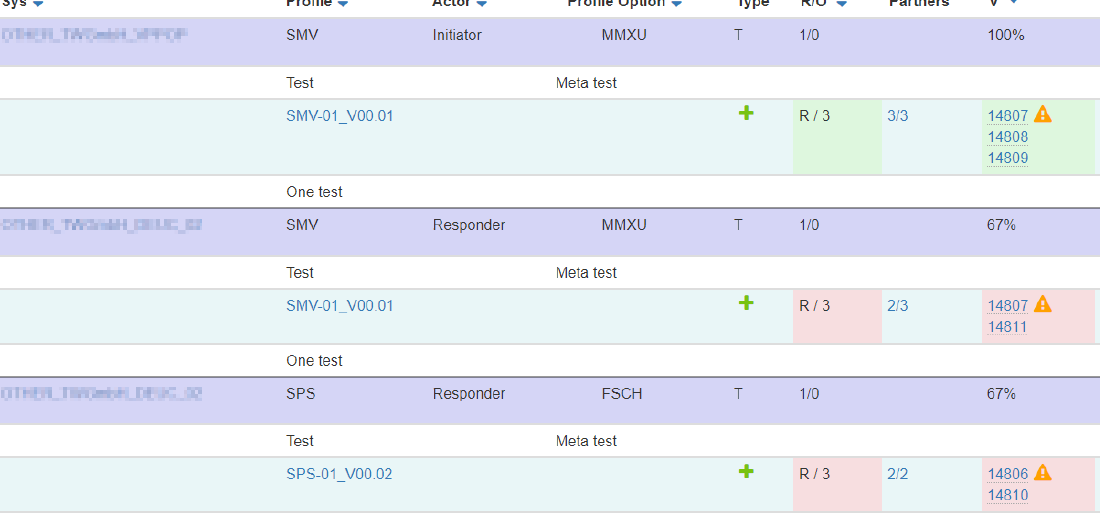
Figure 21. Connectathon 2018 test-results: the VPPOP, DEUOP and DEUC communication interfaces from four different manufacturers were tested on interoperability and compliance with the SMV, SPS and SAC Integration Profile (Gazelle